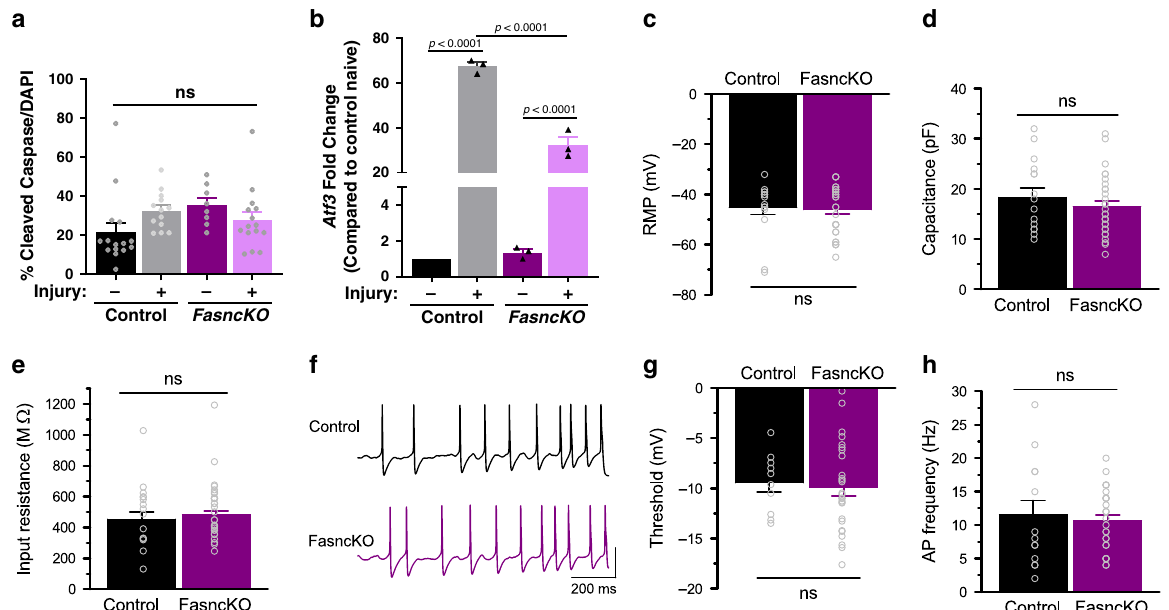
Fig. 5 Fasn deletion in SGC does not alter neuronal functional properties. a Quanti fi cation of cleaved caspase 3 in DRG sections from control and FasncKO mice in naïve and 3 days after sciatic nerve injury. The ratio of cleaved caspase 3 positive vs. DAPI nuclei was measured. n = 4 biologically independent animals. ns-non signi fi cant. b qPCR analysis of Atf3 expression in DRG from control and FasncKO mice in naïve and 3 days after sciatic nerve injury. n = 3 biologically independent animals. c Whole-cell recordings were performed from cultured DRG neurons associated with at least one glial cell, from FasncKO or control mice. Resting membrane potential (RMP) in control − 45.3 ±2.7mV, n = 16 cells from 8 independent experiments; in FasncKO − 46.1± 1.8mV, n = 30; p = 0.79. d Membrane capacitance in control 18.3 ± 1.8pF, n = 16 cells from 8 independent experiments; in FasncKO 16.5 ±1.1pF, n = 30 cells from 8 independent experiments; p = 0.36. e Input resistance in control 456± 43M Ω , n = 16 cells from 8 independent experiments; in FasncKO 482 ±24M Ω , n = 30 cells from 8 independent experiments; p = 0.56. f Spiking properties of DRG neurons from controls and FasncKO . g Action Potential threshold in control − 9.46 ± 0.94mV, n = 13 cells from 8 independent experiments; in FasncKO − 9.91 ± 0.84mV, n = 28 cells from 8 independent experiments; p = 0.77 ns- non-signi fi cant. h Neuronal fi ring rate in control 11.57± 2.09 Hz, n = 14 cells from 8 independent experiments; in FasncKO 10.62± 0.86Hz, n = 29 cells from 8 independent experiments; p = 0.62. ns- non signi fi cant. P values determined by One way ANOVA followed by Sidak ’ s multiple comparisons test in ( a , b ) and two-tailed t test in ( c , d , e , g , h ). Data are presented as mean values ±SEM. Source data are provided as a Source Data fi le for ( a – e , g , h